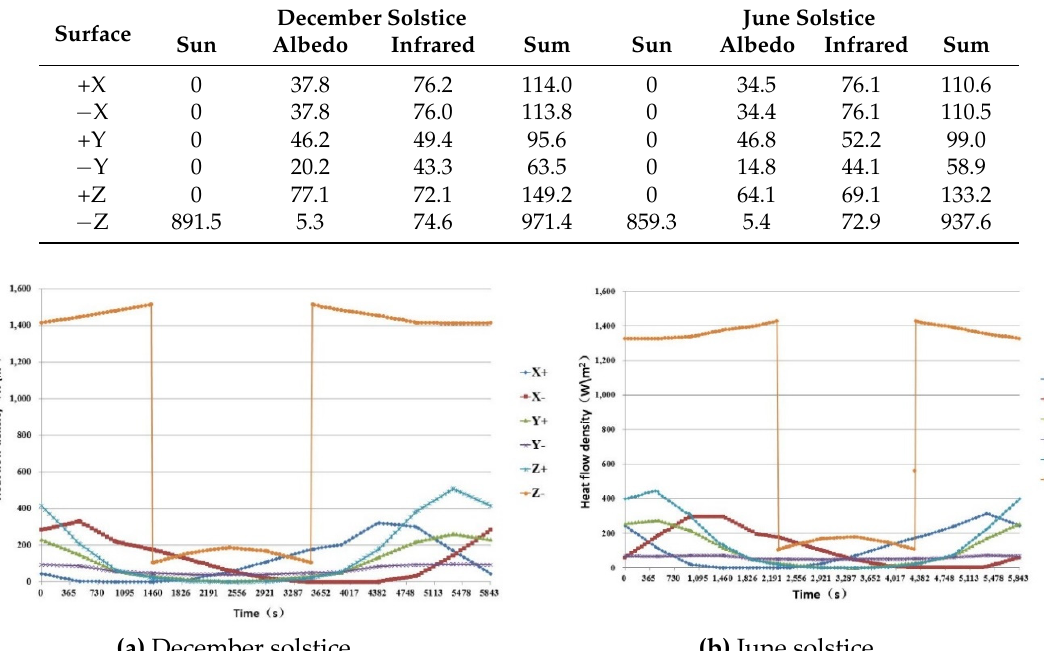
Figure 4. Variation curve of heat flux density on the satellite’s surface.